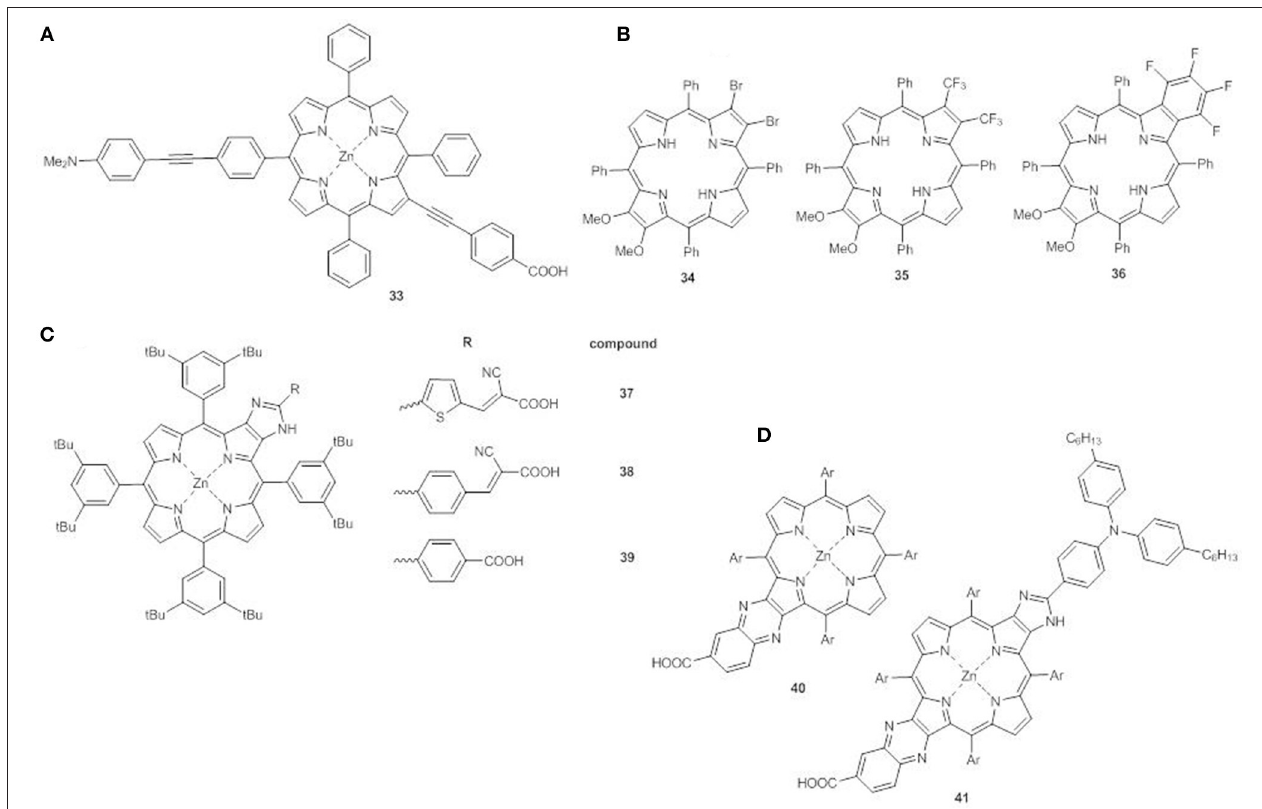
FIGURE 14 | (A) meso - β disubstituted Zn II porphyrin 33 ; (B) multi β -substituted free base porphyrins 34 - 36 ; (C) β -functionalized imidazole-fused porphyrin dyes 37-39 ; (D) push-pull fused Zn II porphyrins 40-41